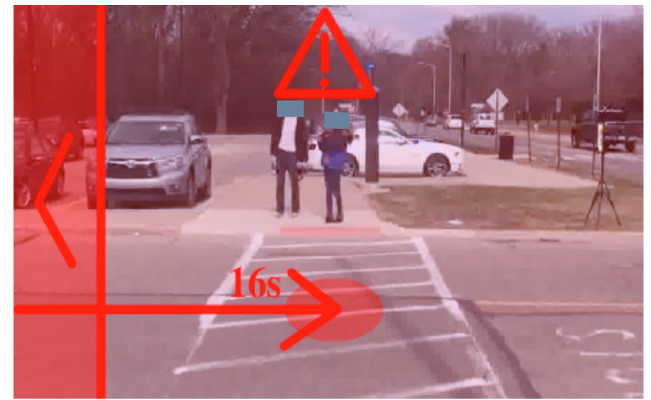
Figure 3. User interface overlapped with a real-world view.